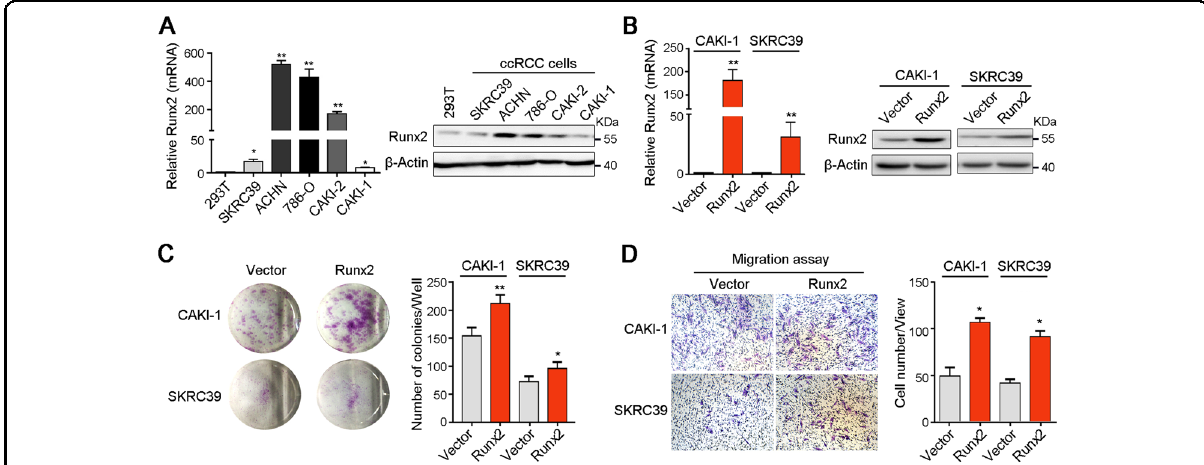
Fig. 2 Exogenous overexpression of Runx2 enhances the proliferation and migration of ccRCC cells. A The expression level of Runx2 in one human immortalized renal epithelial cell and fi ve ccRCC cells was analyzed by qRT-PCR and western blot analyses, respectively. β -Actin was also tested as a loading control. B Plasmid-mediated transfection was used to overexpress the Runx2 in CAKI-1 and SKRC39 cells, and the expression level of Runx2 was con fi rmed by qRT-PCR and western blot analyses. C Foci formation assay showed that overexpression of Runx2 promoted ccRCC cells growth. D Migration assay suggested that the migration ability of ccRCC cells was increased after overexpression of Runx2, compared to control cells. In all panels, *, P < 0.05; **, P <